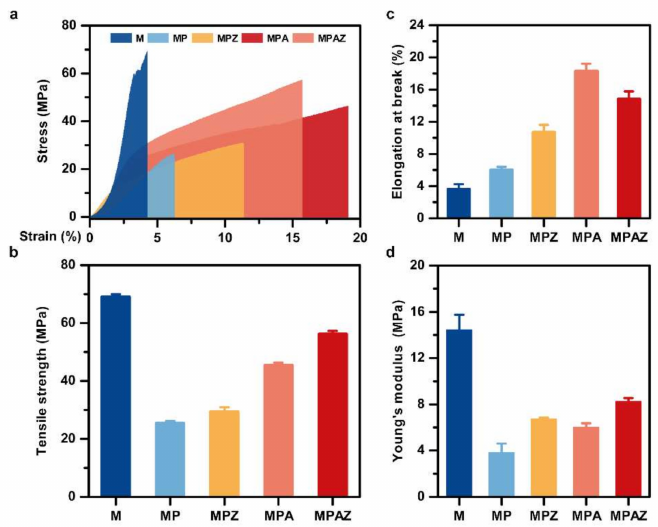
Figure 5. Mechanical properties of different films. ( a ), Stress-strain curves; ( b ), tensile strength; ( c ), elongation at break; ( d ), Young’s modulus.